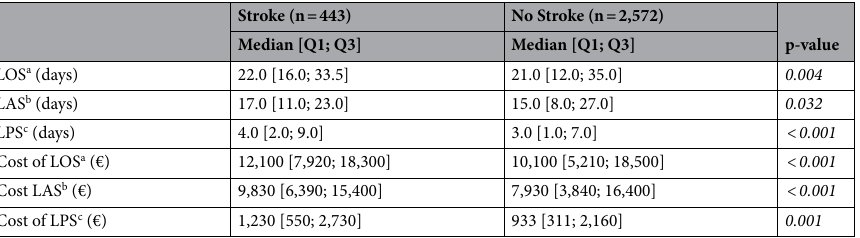
Table 1. Comparison of cases with stroke versus other cases of delayed discharge for non-clinical reasons: length of stay and costs. Cantabria (Northern Spain), 2007–2015. a LOS, Length of total stay; b LAS, Length of appropriate stay; c LPS, Length of prolonged